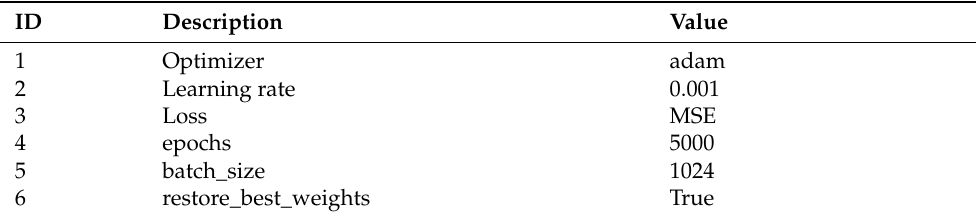
Table 4. Hyper parameters of the BPNN for tire wear prediction.